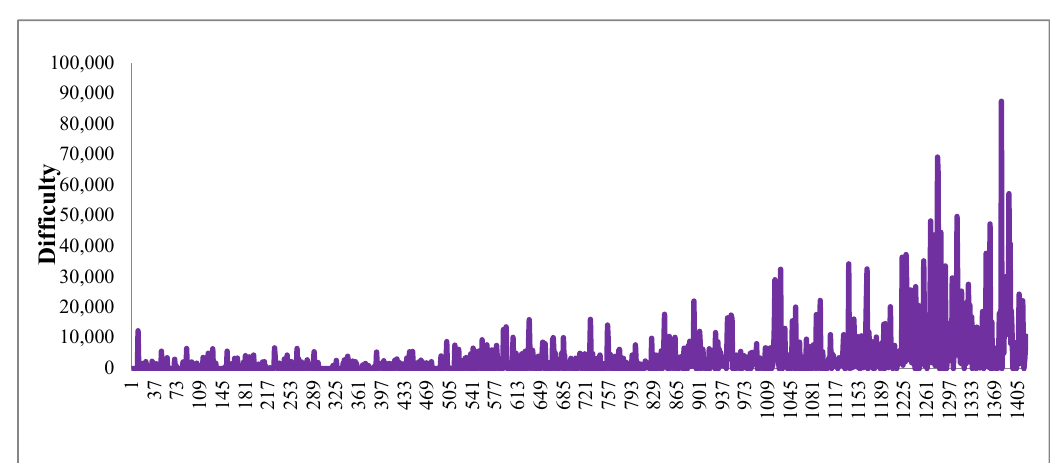
Figure 7. Displacement while weights set as [0,1,0] in test 2.